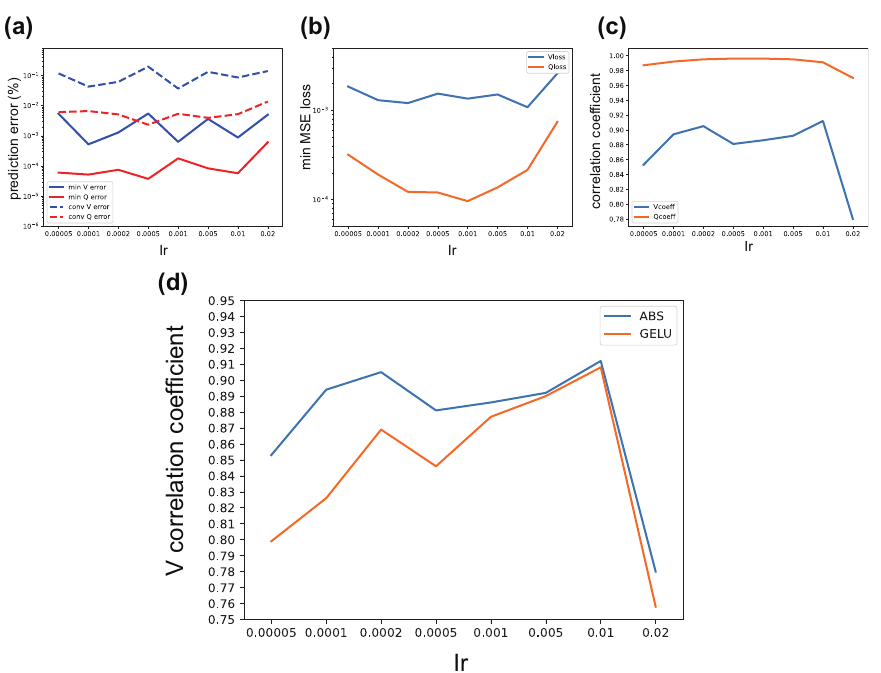
Figure 5. Model performance as a function of learning rates (lr). ( a ): prediction errors vs. lr, conv stands for converged; ( b ): minimum MSE loss vs. lr; ( c ): correlation coefficients vs. lr; ( d ): V coef f calculated with activation functions ABS and GELU vs. lr, respectively. For each plot, eight lr values ranging from 0.00005 to 0.02 are chosen. Data points are mean values between three separate